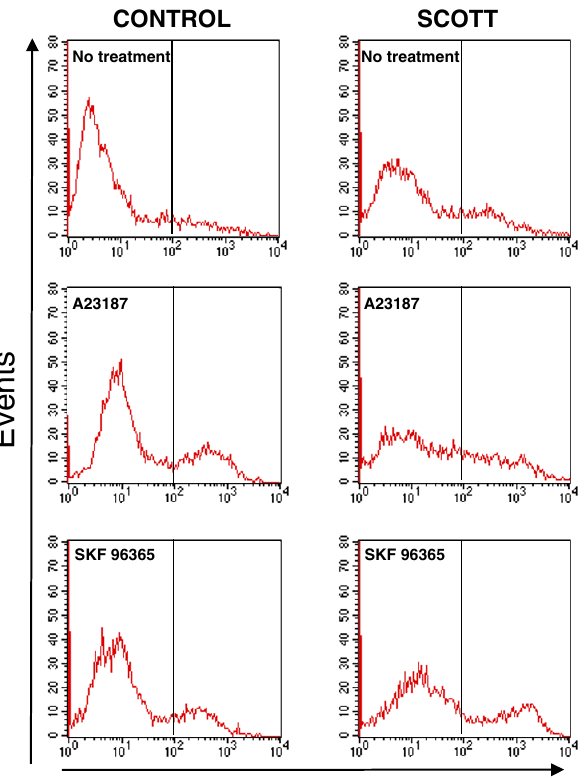
Figure 7 Phosphatidylserine exposure assessed by Annexin V-labeling after apoptosis induction in control and Scott cells. Cells, treated for 72 h by 200 nM A23187 or 10 µ M SKF 96365, were loaded with the fluorochrome Fluo-3 (3 µ M) and annexin V-biotin (5 µ l at 0.5 mg/ml) and labeling was achieved with phycoerythrin-conjugated streptavidin. Results are expressed as phycoerythrin fluorescence versus cell number. The cell populations with high annexin V labeling correspond to those with high Fluo-3 fluorescence (Fig. 4). One